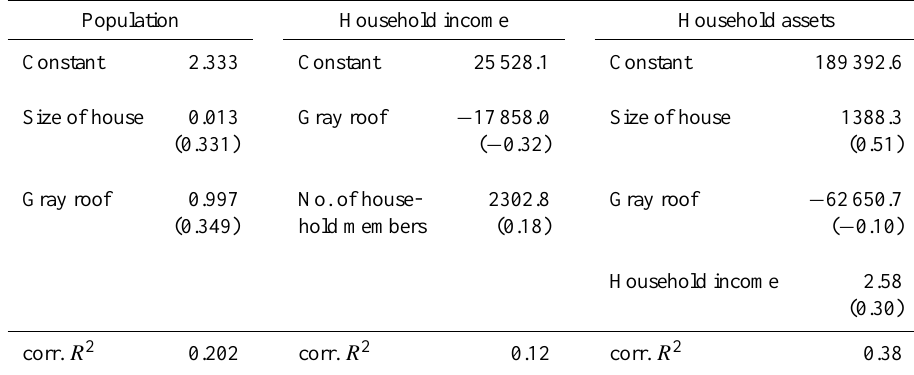
Table 3. Regression model for household assets (own calculations based on TRAIT household survey).